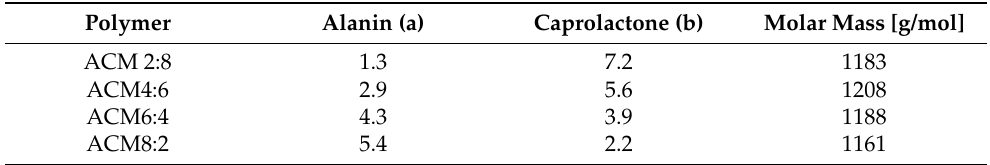
Figure 3. 1H-NMR Spectra of Poly-(Alanine- ε -Caprolactone)dimethacrylate with different ratios of alanine and caprolacton. Table 1. Results from 1H-NMR Analysis of ACM derivates: Calculation of Alanin and caprolacton content as well as molar mass.